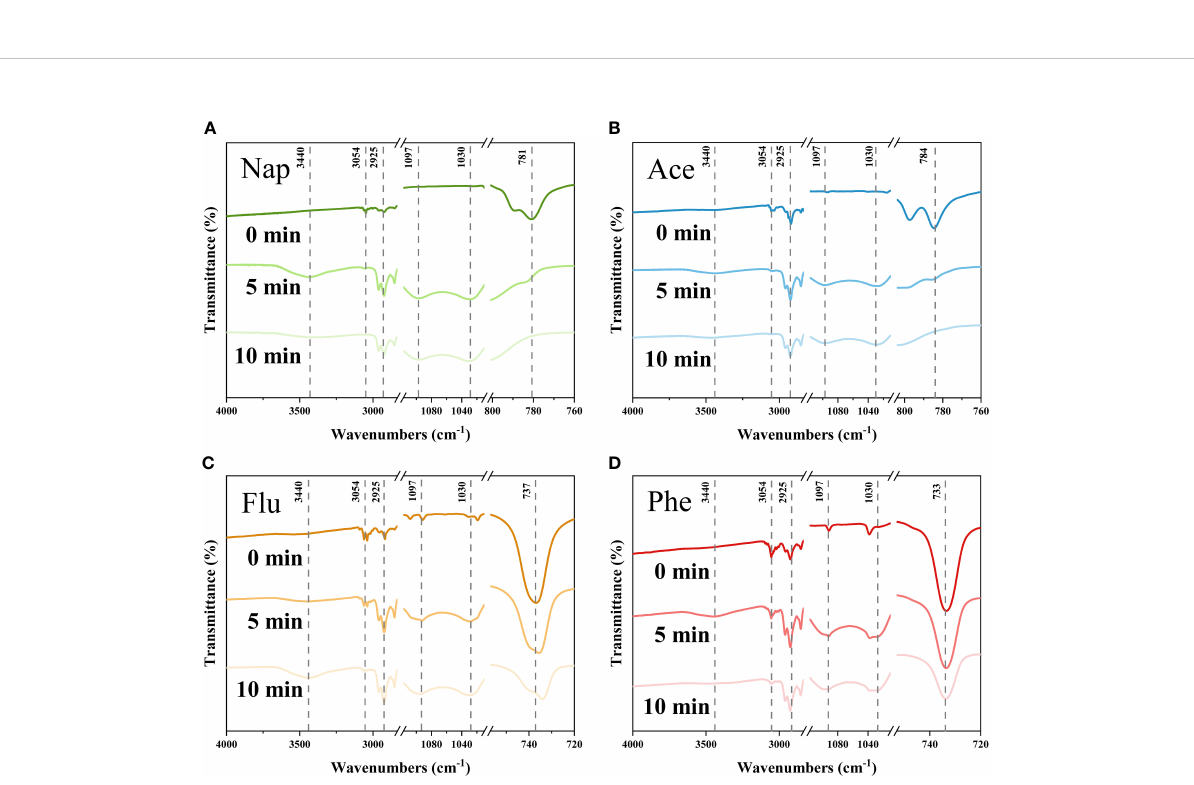
FIGURE 5 FTIR spectra of (A) Nap, (B) Ace, (C) Flu, and (D) Phe before and after the liquid phase plasma treatment. The characteristic peaks of PAHs in the range between 600 – 900 cm -1 decreased. Moreover, hydroxyl and oxygen groups are formed after the treatment in the region of 3,160 – 3,600 cm -1 and 1,000 – 1,260 cm -1 ,